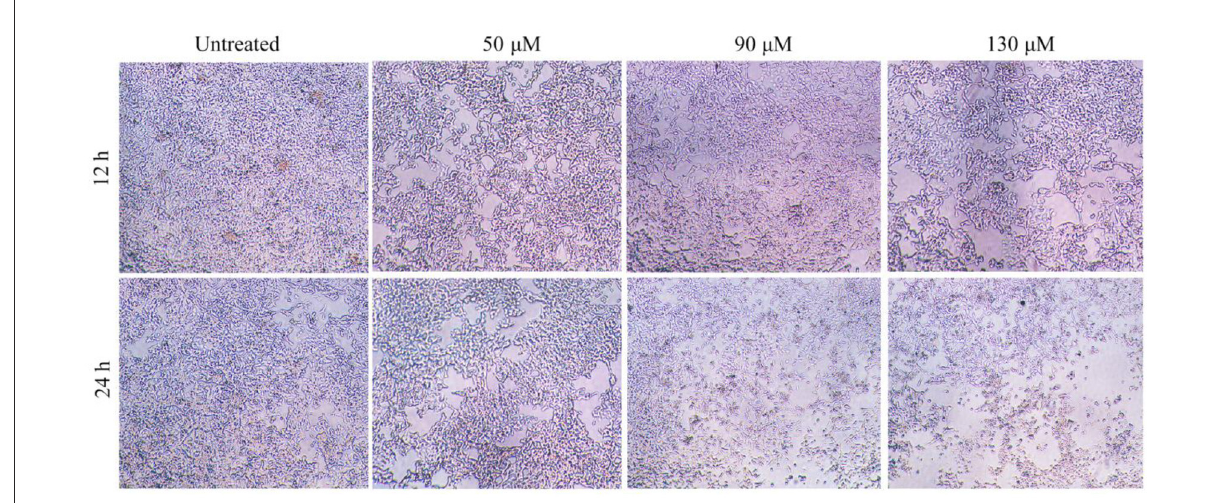
FIGURE4 Effects of hydroxy- γ -sanshool (HRS) on morphological changes in HCT-116 cells. The original magnification was × 200.